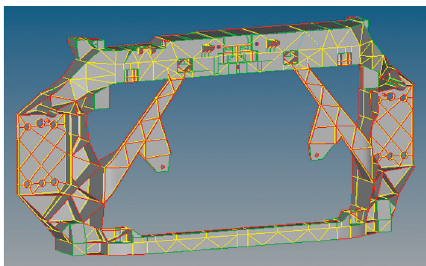
Figure 13: Results of the mid-surface treatment of the automotive all-plastic front-end frame.